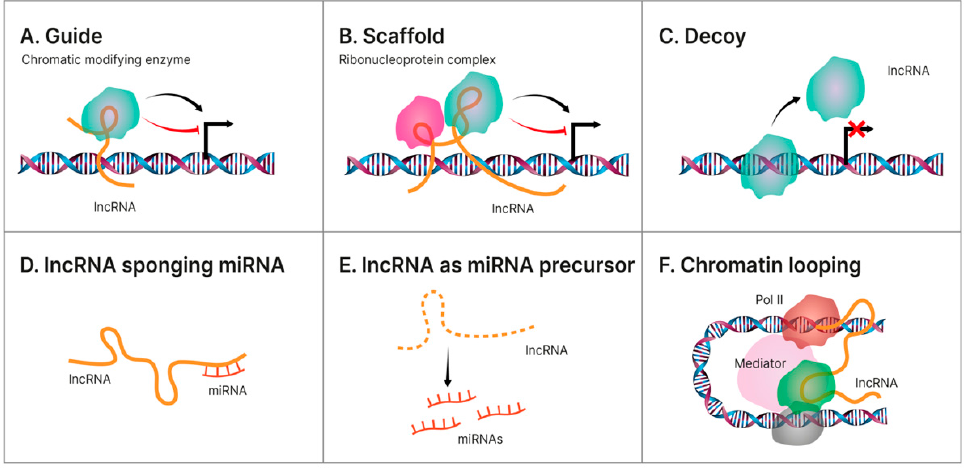
Figure 1. Different mechanisms of action for lncRNAs. Illustration of the main regulatory mechanism endorsed by hepatic lncRNAs in the pathology transition of NAFLD towards HCC. ( A ). Guide—some lncRNAs aid specific proteins to reach their target, thus accomplishing their biological functions. Oftentimes, some of these proteins are transcription factors located on specific DNA regions and this guidance becomes an indirect way of regulating gene transcription; ( B ). Scaffold—LncRNA can facilitate the interaction of numerous molecules and proteins, enabling the assembly of different macromolecular complexes, thus promoting the conjunction and integration of molecular information within different signaling pathways; ( C ). Decoy—some lncRNAs bind directly to some pro- tein molecules impairing their functions; ( D ). lncRNA sponging miRNA—some lncRNAs can act as ceRNAs, or sponges, reducing their effect upon the target mRNA, thus regulating gene expression; ( E ). lncRNA as miRNA precursor—some lncRNAs can act as precursors of miRNAs to directly mod- ulate their regulatory activity; ( F ). Chromatin looping—as lncRNAs are long and mobile, they could serve as bridges to drive the inter- or intra-chromosomal interactions.